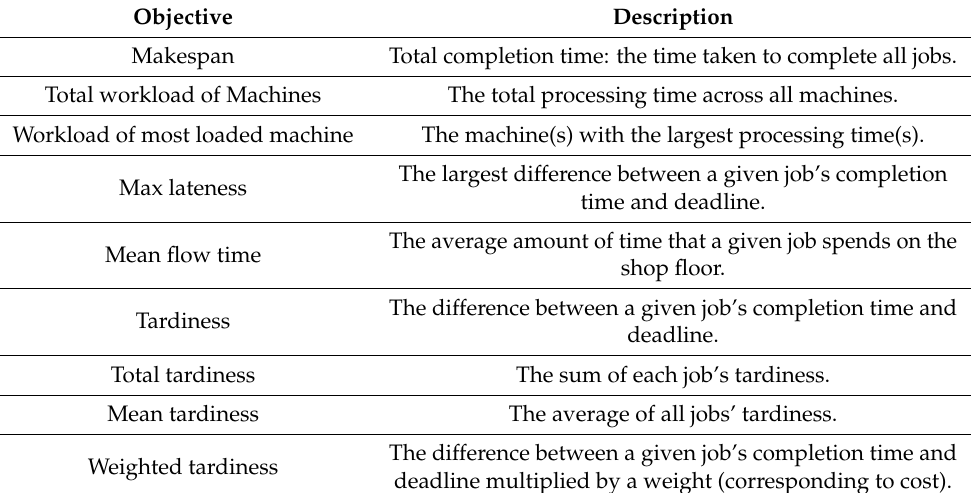
Table 4. Commonly used objective (performance measure) in different manufacturing